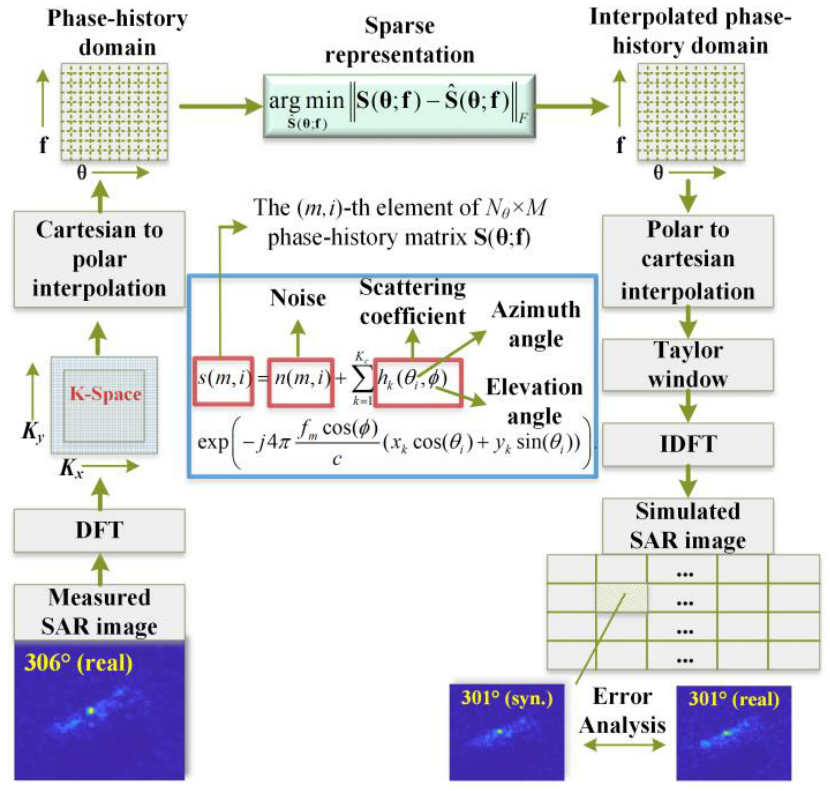
Figure 3. Flowchart of interpolation in the phase-history domain for SAR image data augmenta- tion.